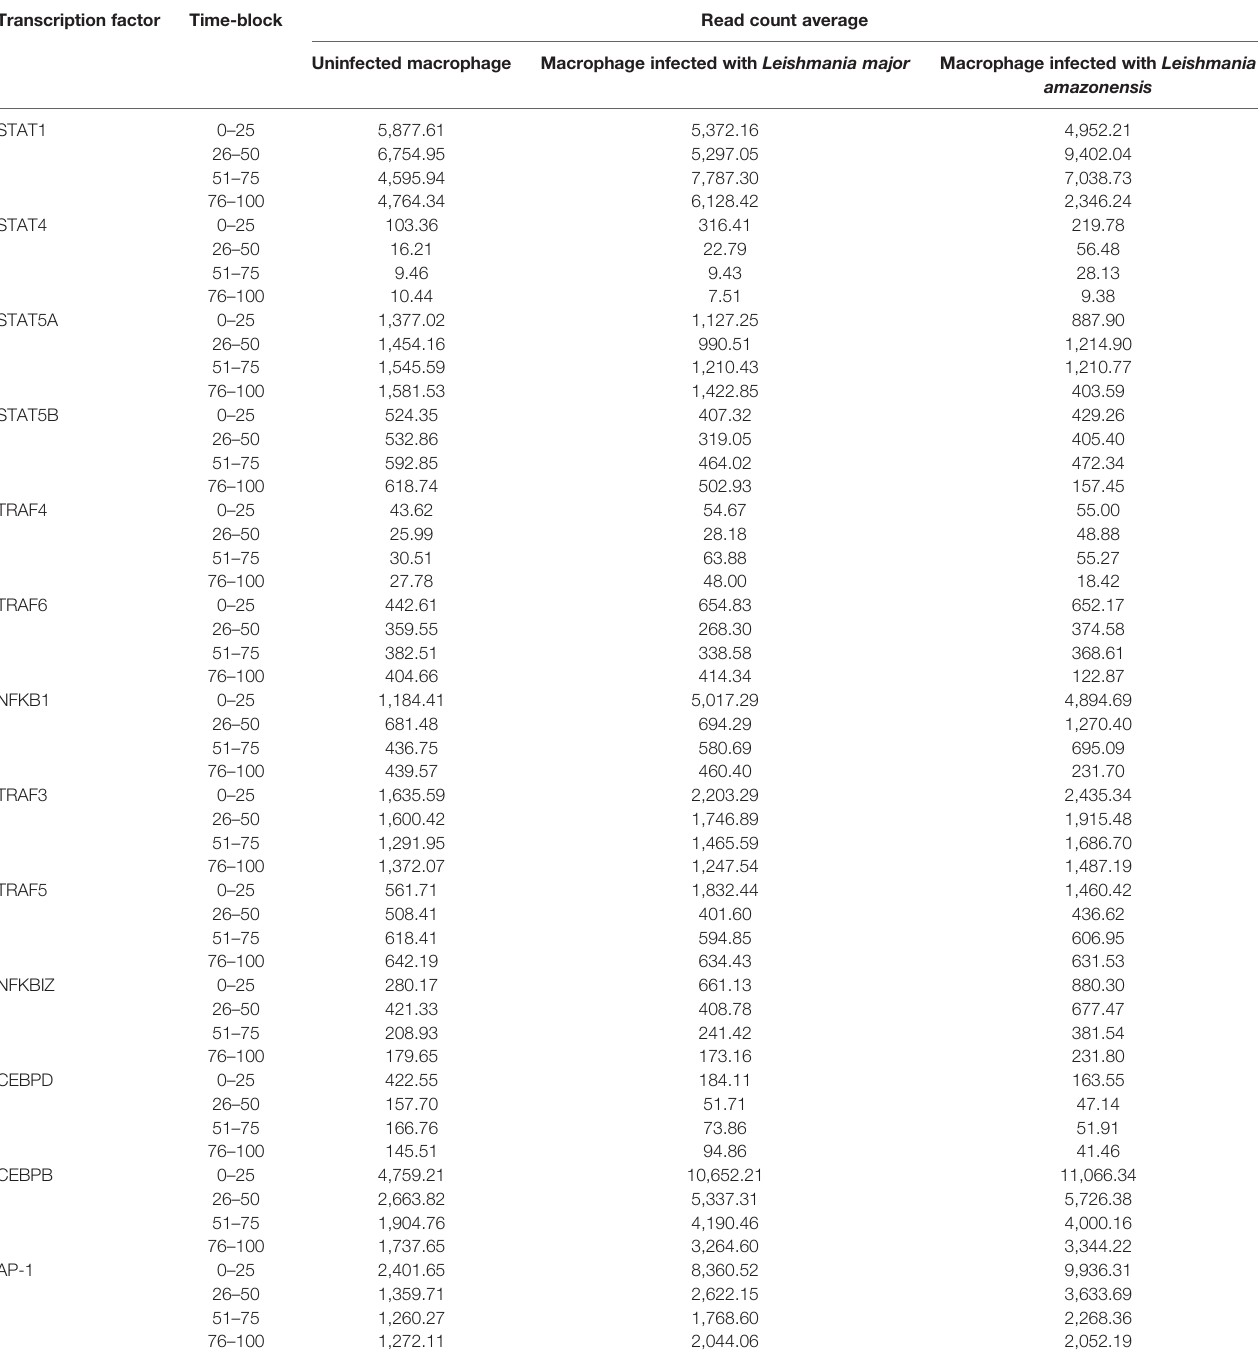
TABLE 2 | Read count average for each transcription factor in IL-17 pathway for each time-block de fi ned interval. Transcription